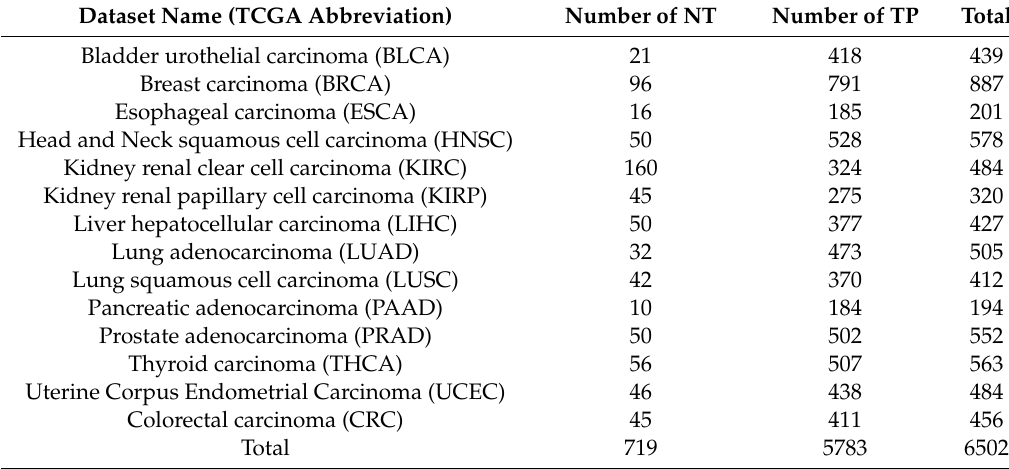
Figure 2. Map of the 22 GSDME GpGs showing the average probe methylation and chromosomal location across the different datasets. The size of the dots indicates the average methylation, while the colour indicates tissue type (NT = normal tissue, TP = tumor tissue). Please refer to Table 1 for tumor dataset abbreviations. Table 1. Overview of the The Cancer Genome Atlas (TCGA) datasets used for the